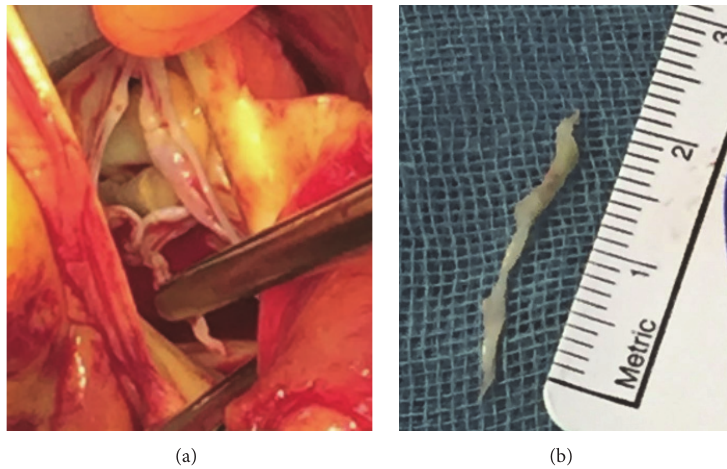
Figure 5: (a) Surgical view of the aortic valve. The excrescence is clamped and then (b) removed.